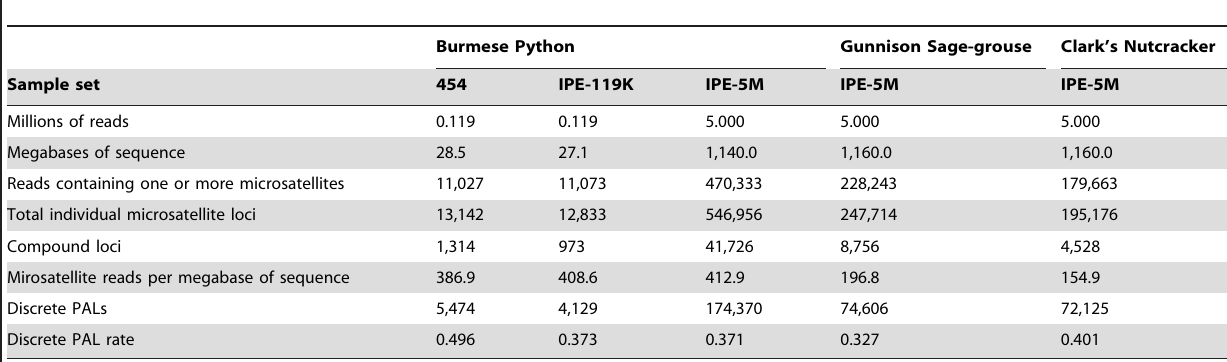
Table 1. Summary of microsatellite identification from various python and bird genome sequence sets.